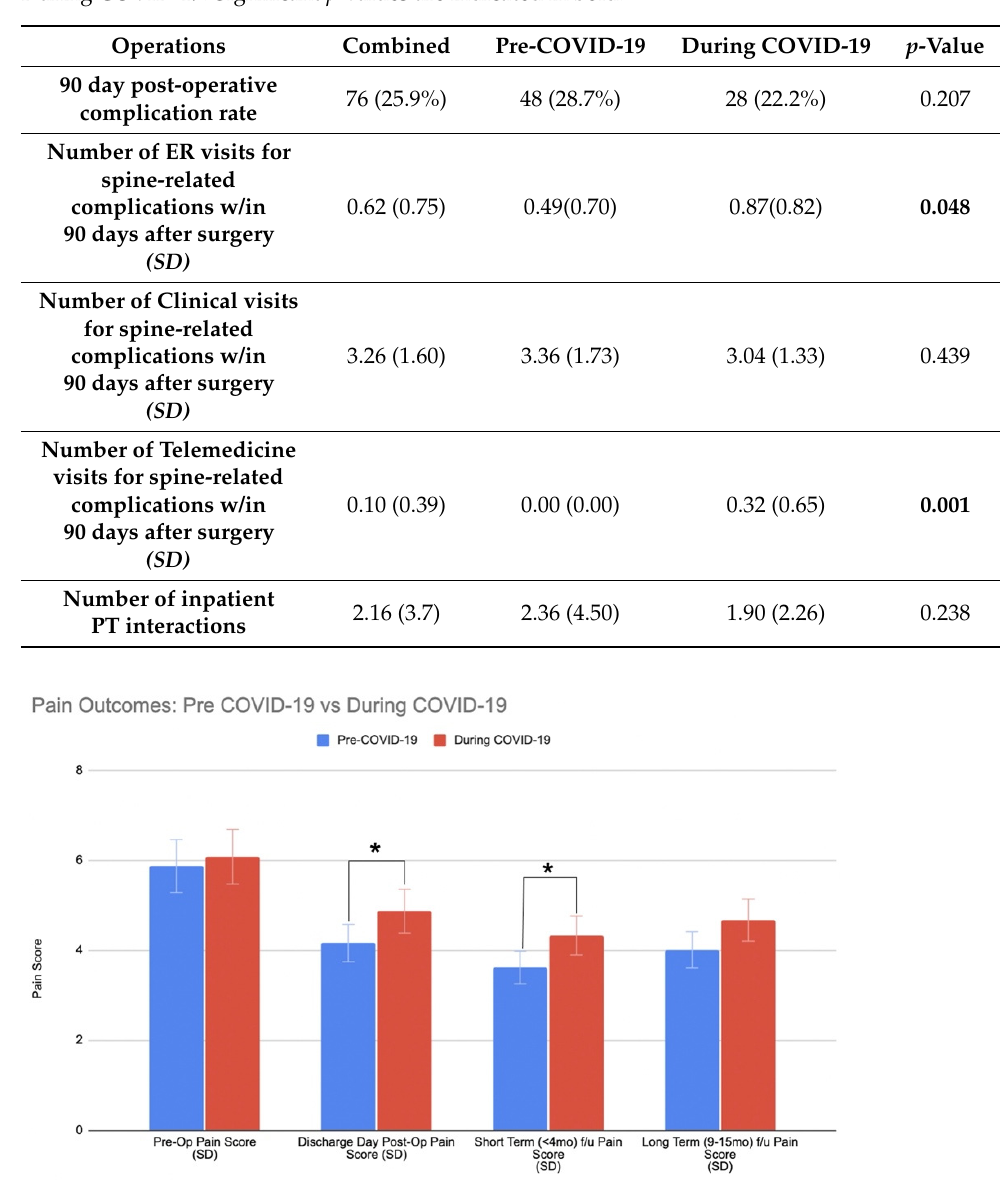
Figure 3 . Pain Outcomes . Significant group differences are indicated with an asterisk (*). Figure 3. Pain Outcomes. Significant group differences are indicated with an asterisk